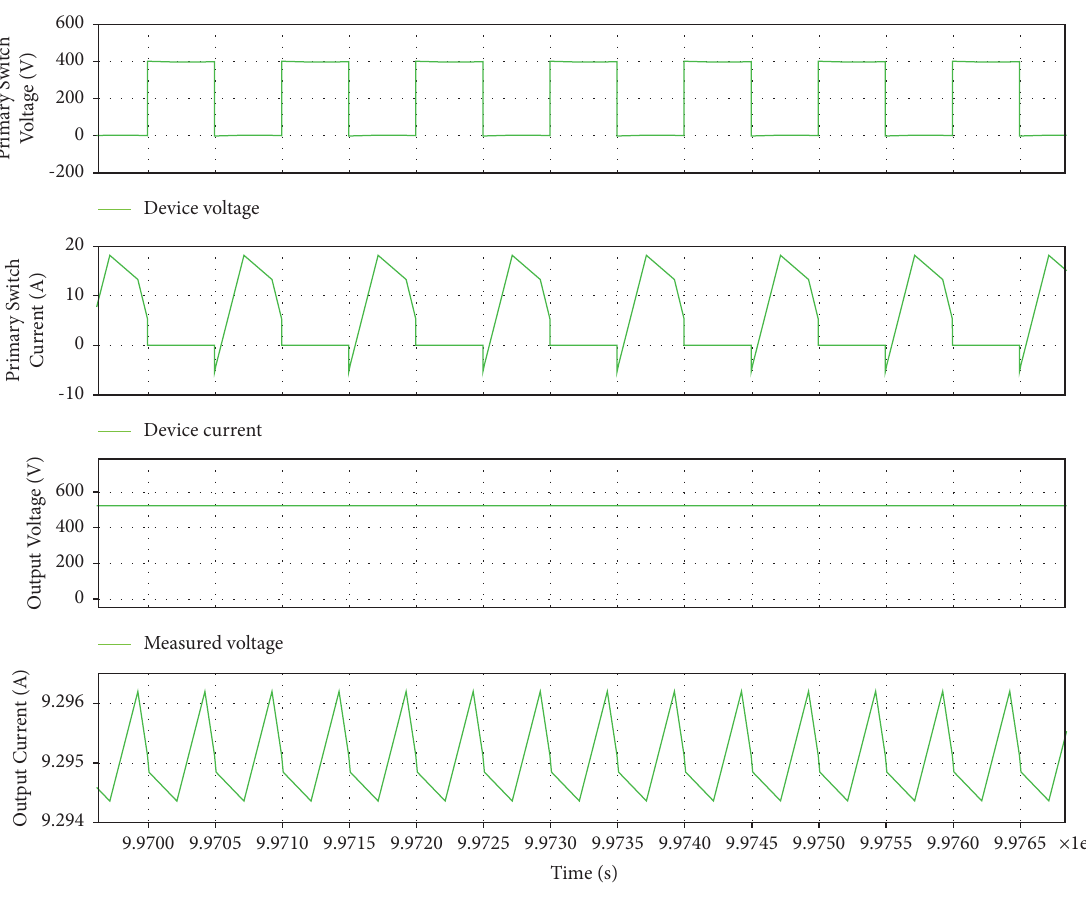
Figure 15: Simulated waveforms for the Si power transistor-based